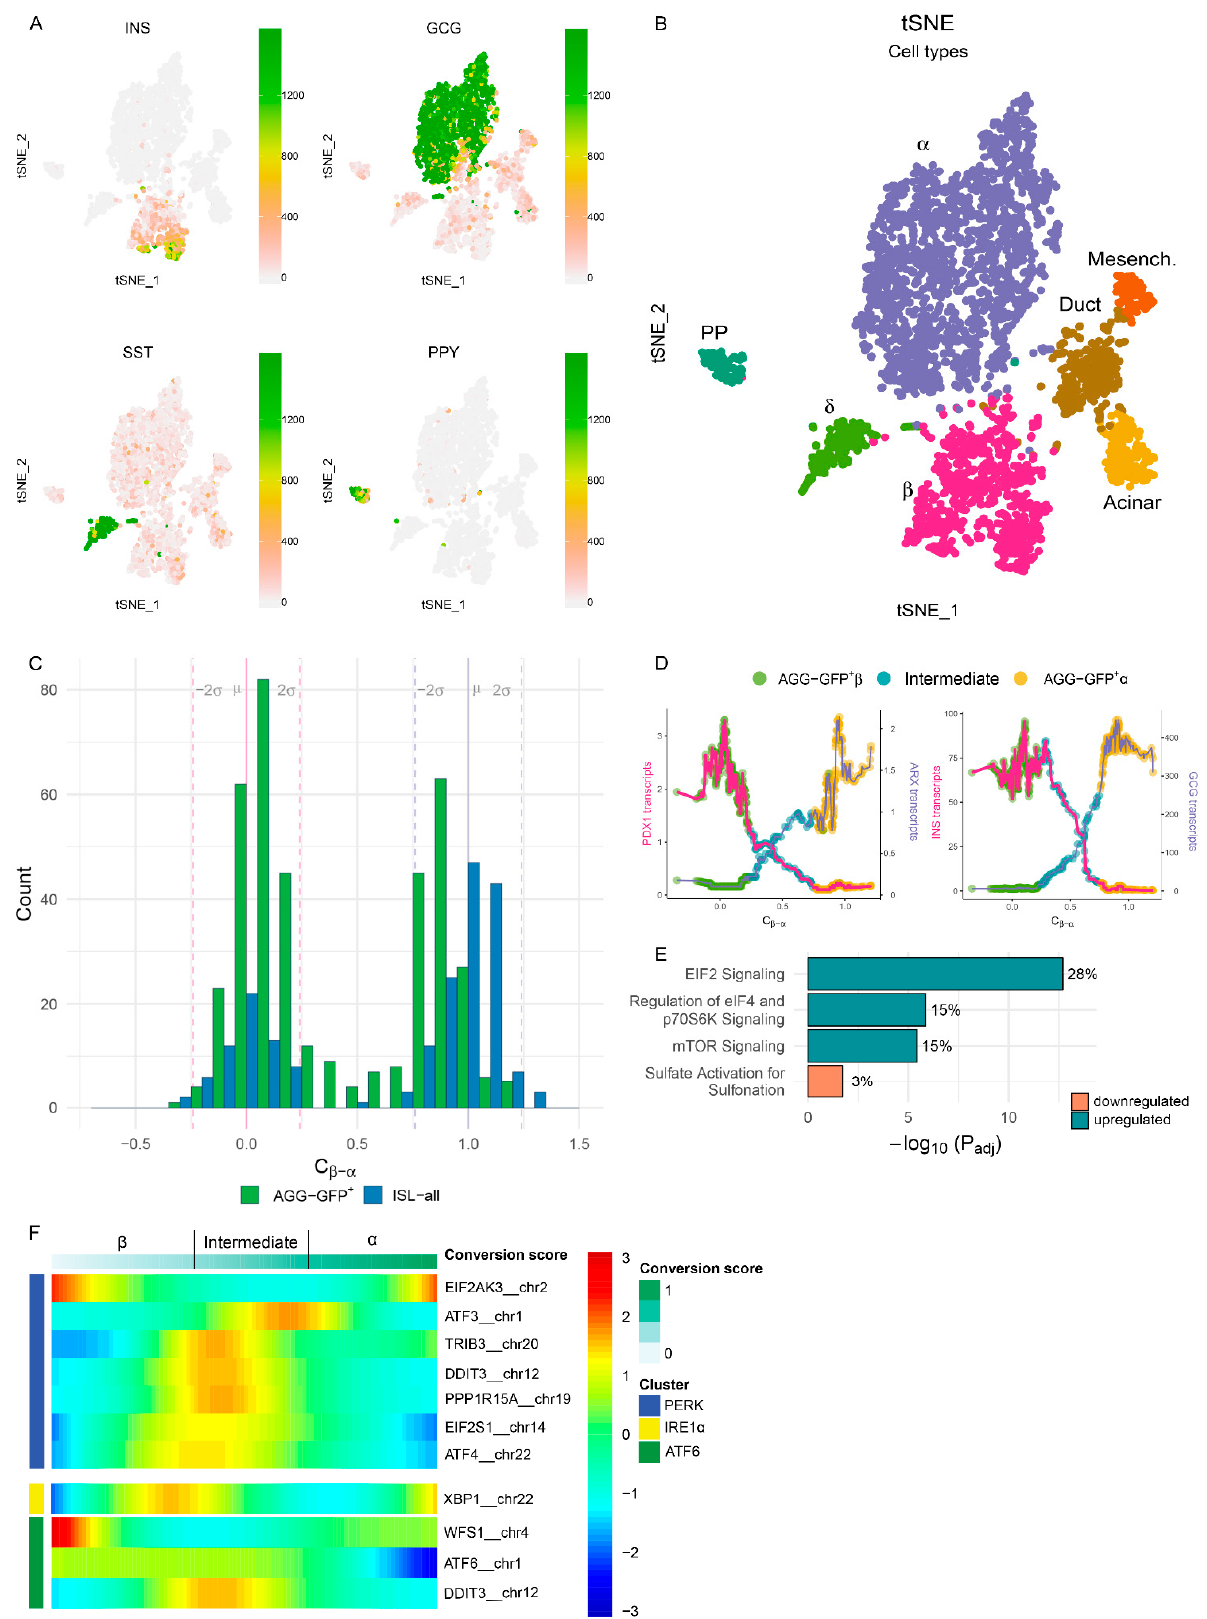
Figure 1. scRNAseq and pseudo-temporal ordering of β -cells show that loss of identity is associated with the upregulation of stress markers. ( A ) In total 4093 cells from three donors were processed for scRNAseq using setup 1 (Figure S1).